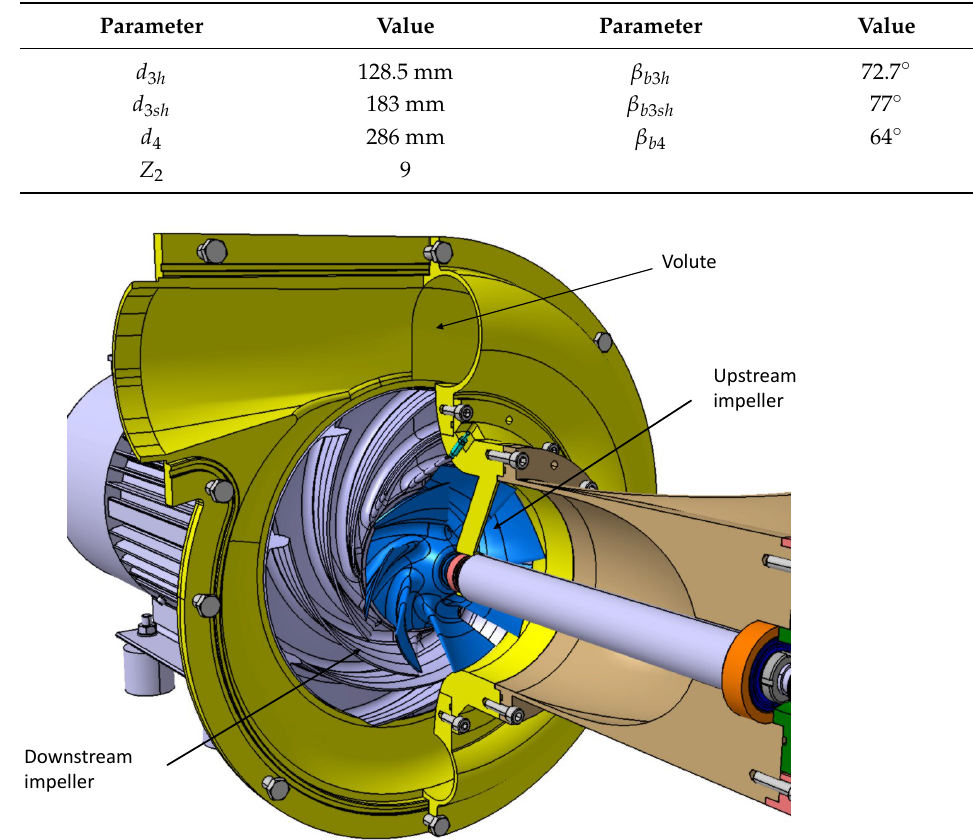
Table 2. Downstream-impeller geometric parameters.